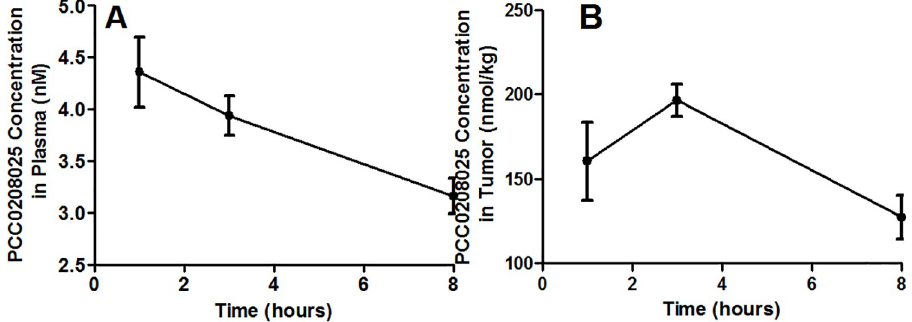
Fig 8. Pharmacokinetics of PCC0208025 in plasma and tumors in melanoma-bearing mice. After a single dose of 60 mg/kg PCC0208025, average concentrations were about 4.36, 3.94 and 3.16 nM in plasma at 1h, 3h and 8h, respectively (each time point, n = 5); and about 160.7, 196.7 and 127.3 nmol/kg in tumor at 1h, 3h and 8h, respectively (each time point, n = 5).